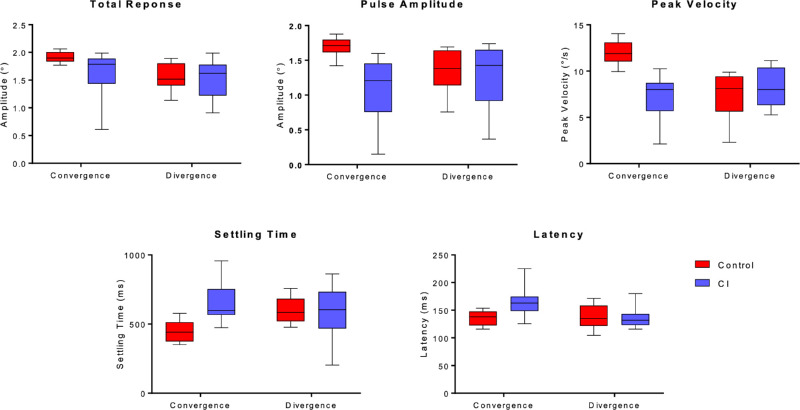
Properties of vergence responses to the 2° disparity step stimulus in the final block of the baseline phase. Box plots represent the within-group variance of the mean of each parameter.